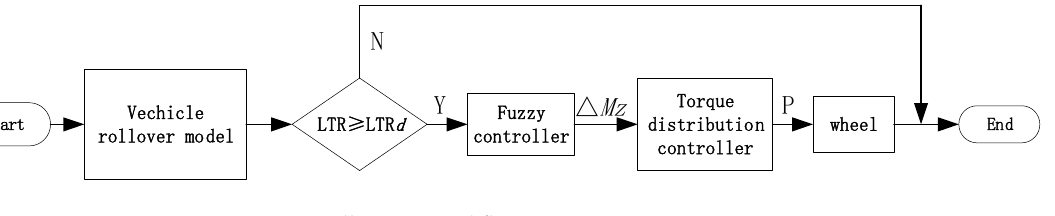
Figure 4. Anti-rollover control flow.